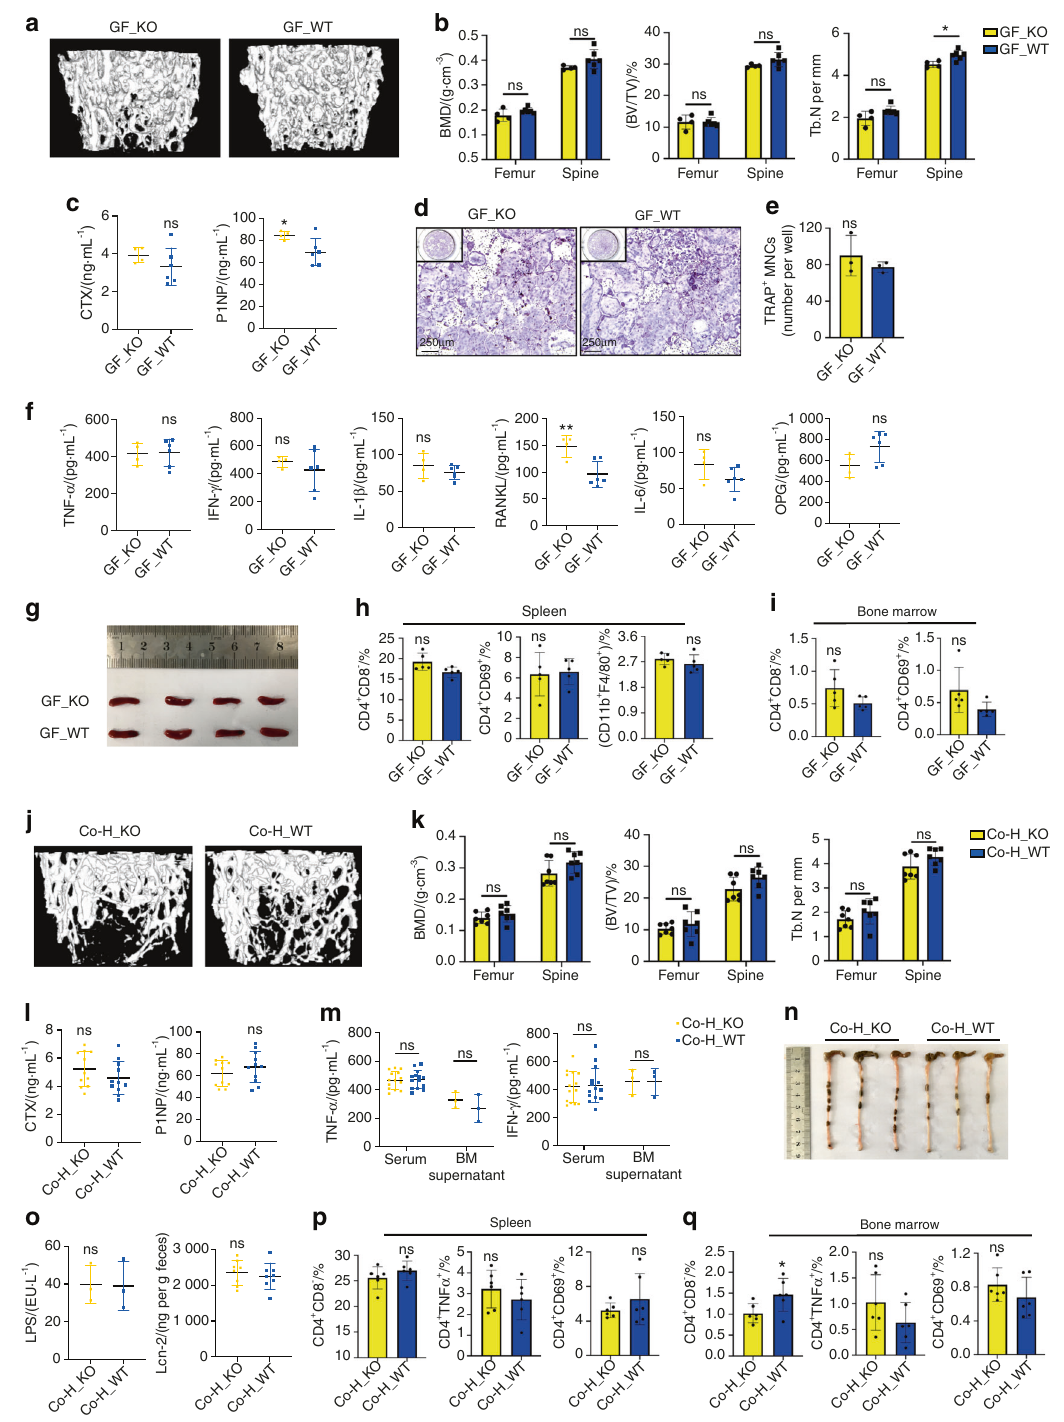
Fig. 4 Altered gut microbiota played an important role in the systemic in fl ammation and bone loss in TLR9 − / − mice. a – i Phenotypic study of 8-week-old male germ-free (GF) TLR9 − / − and wildtype mice. a Representative 3D μ CT images of the femurs. b Trabecular BMD, BV/TV, and Tb. N of femurs and L3 vertebrae in each group. GF_KO, n = 4; GF_WT, n = 6. c Circulating CTX and P1NP levels. GF_KO, n = 4; GF_WT, n = 6. d – e In vitro osteoclastogenesis using BMNCs from the GF mice. d TRAP-stained OCLs. e Quanti fi cation of OCL numbers. f Circulating cytokine levels. GF_KO, n = 4; GF_WT, n = 6. g Spleens from each group. h – i Flow cytometry analysis of splenic CD4 + T cells and macrophages ( h ) and bone marrow CD4 + T cells ( i ). n = 5 per group. j – r The cohousing experiment. j Representative 3D μ CT images of the femurs. k Trabecular BMD, BV/TV, and Tb. N of femurs and L3 vertebrae in male Co-H_KO and Co-H_WT mice. n = 7 per group. l Serum CTX and P1NP levels. n = 11 per group. m TNF α and IFN γ levels. Serum, n = 14 per group; BM supernatant, n = 3 per group. n Large intestines from male Co-H_KO and Co-H_WT mice. o Serum LPS and fecal Lcn-2 levels. LPS, n = 3 per group; Lcn-2, n = 8 per group. p , q Spleen ( p ) and bone marrow ( q ) CD4 + T cell populations by fl ow cytometry. n = 6 per group. Twelve-week-old sex-matched mice were used in l , m and o – q . The numbers in h , i , p